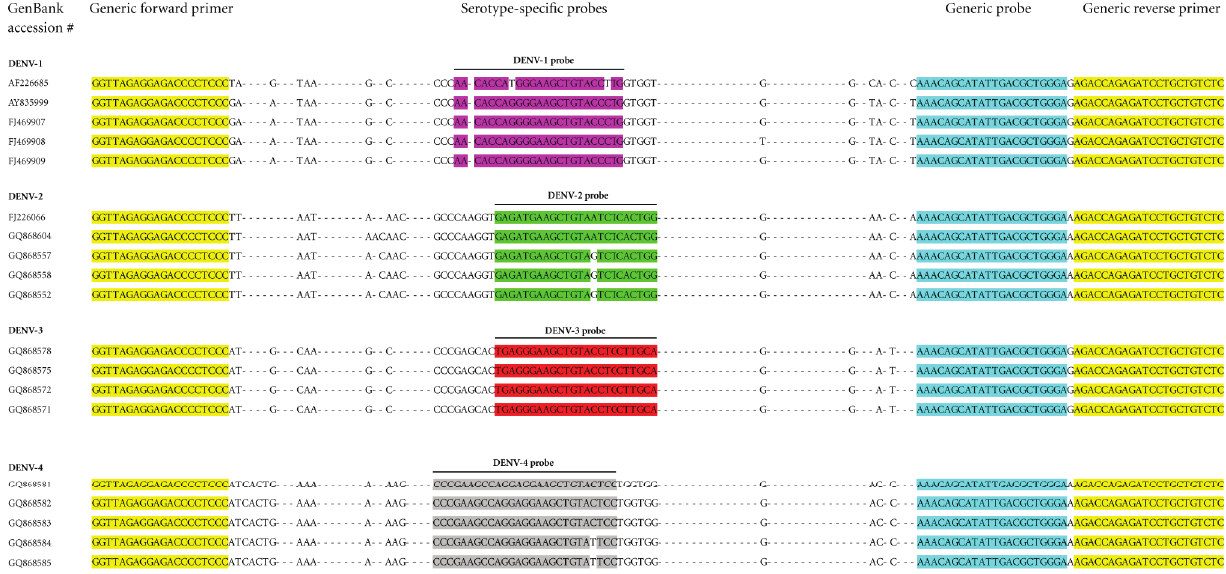
Figure 2: Multiple sequence alignments of DENV 3 (cid:3) UTR region deduced from complete genome sequences of dengue serotypes 1–4 (DENV 1–4) obtained from GenBank showing primers and probes sequences used in generic and/or multiplex real-time PCR with serotype-specific probes for detection of DENV in vitro RNA and DENV in patient samples.